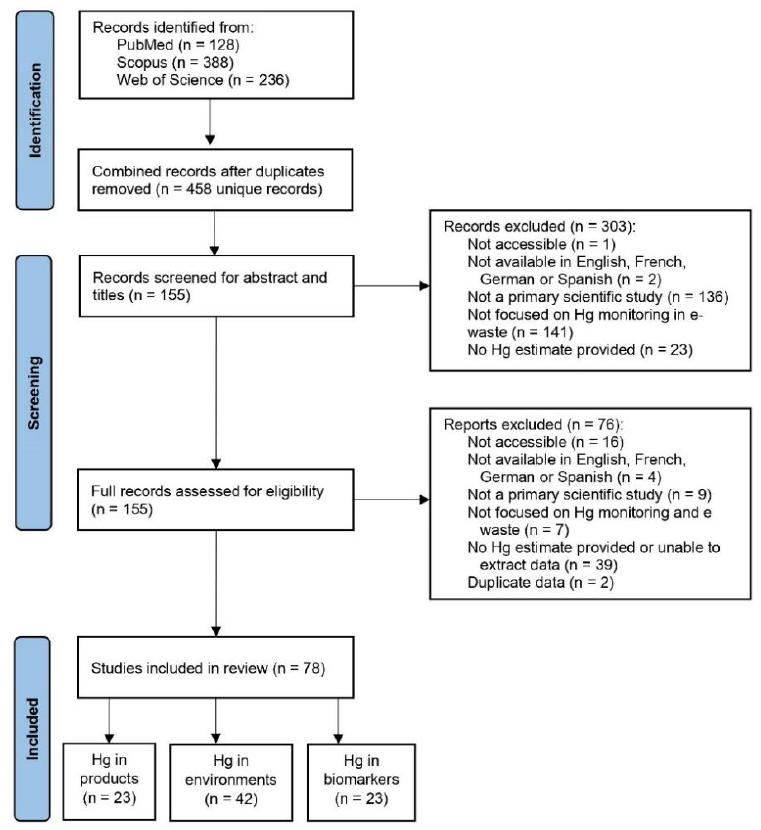
Figure 1. PRISMA chart indicating the number of articles that were identified, screened, and included in this literature review for the three main study groups.